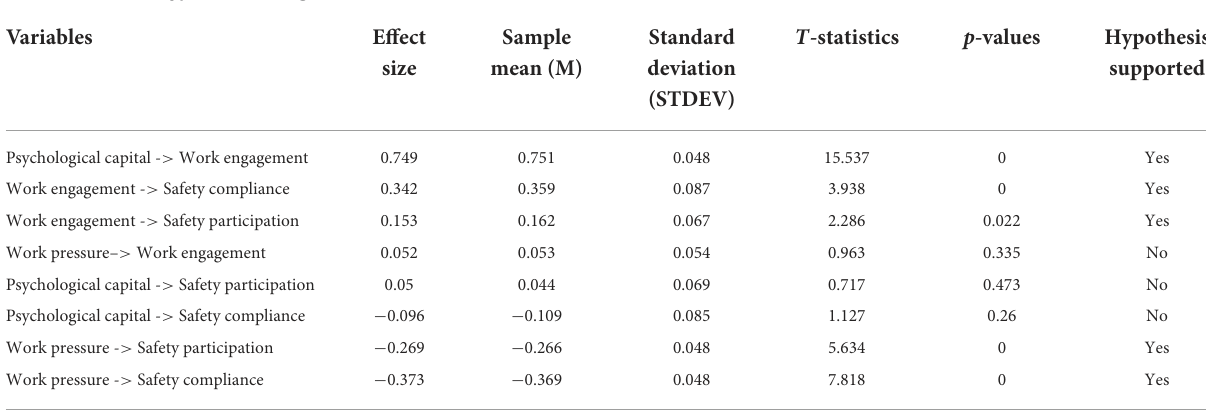
TABLE 4 Result of hypothesis